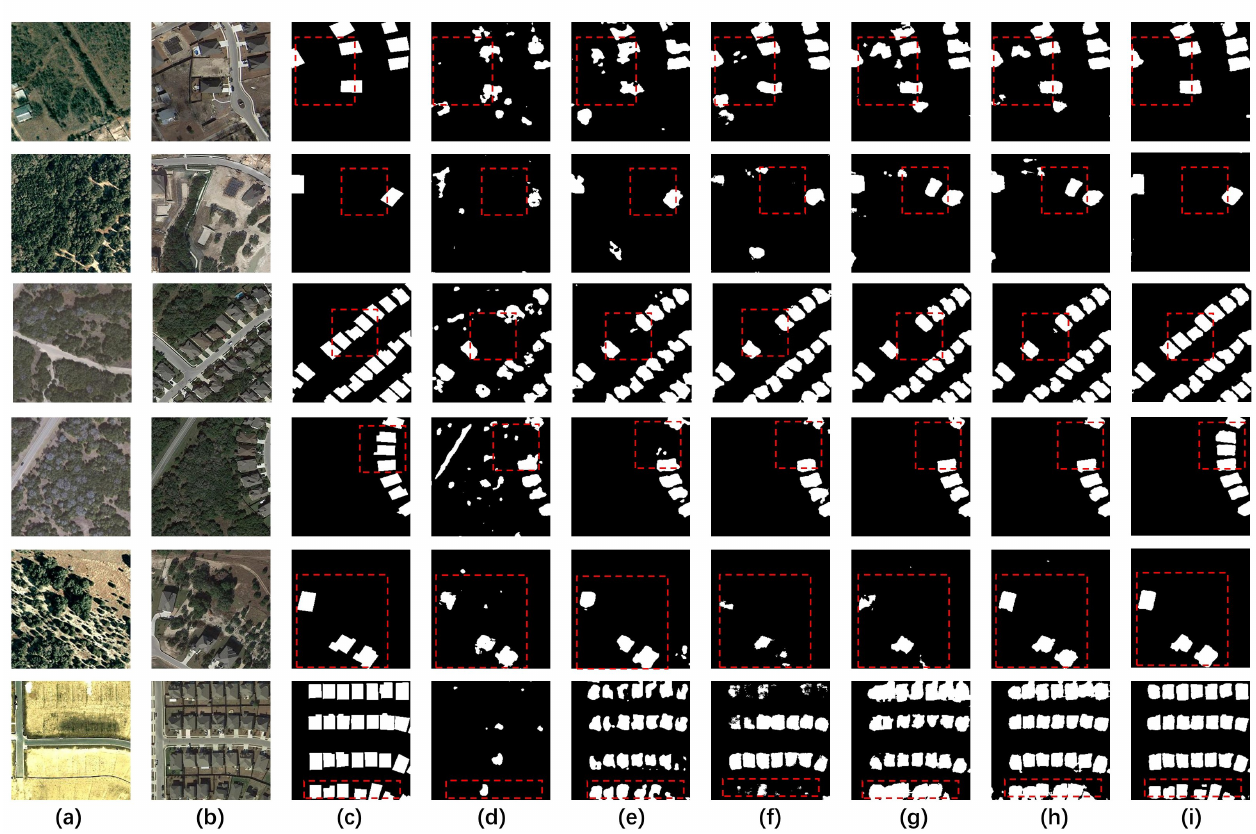
Figure 6. Visual comparisons of CD maps by different approaches on LEVIR2000 dataset using 10% labeled images for training. ( a ) Image T 1 .( b ) Image T 2 . ( c ) Ground truth. ( d ) Fc-Diff. ( e ) Fc-Conc. ( f ) SNUNet-ECAM. ( g ) s4GAN. ( h ) semiCDNet. ( i )